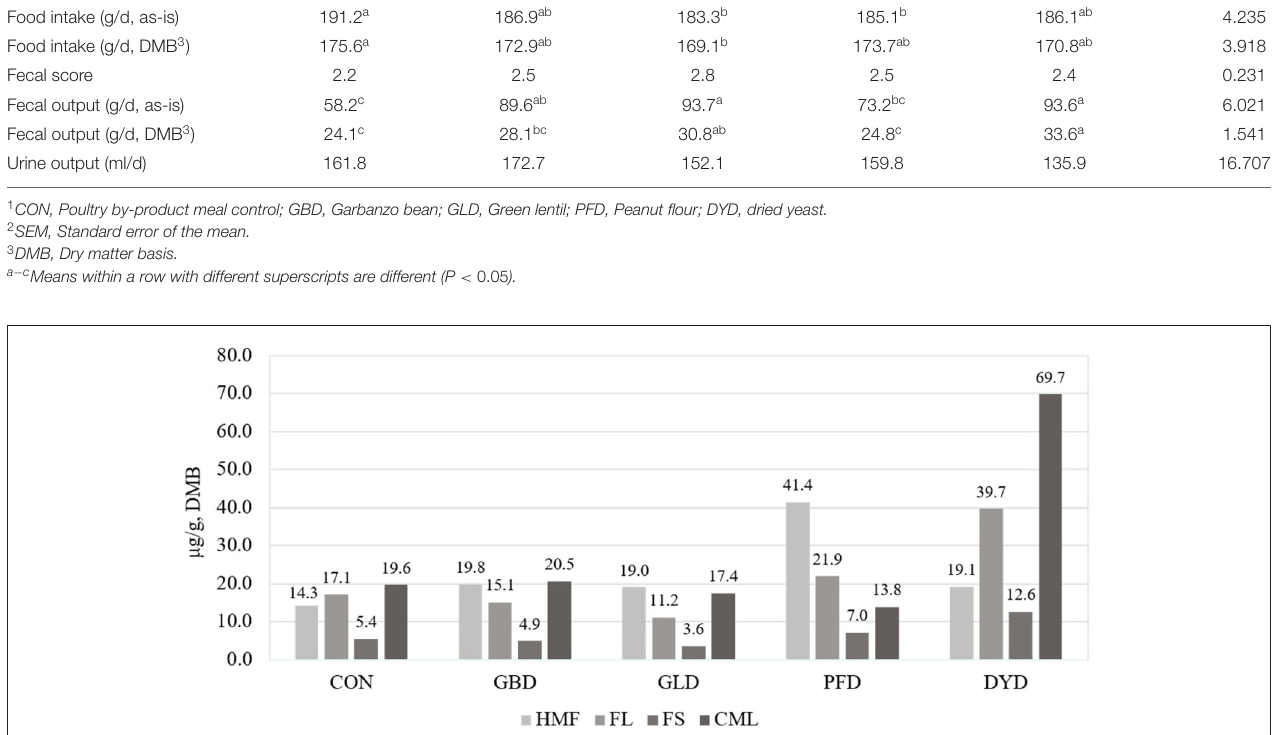
remaining dietary treatments was narrower from 3.6 µ g/g (GLD) to 7.0 µ g/g (PFD). Lastly, for CML, the remaining diets